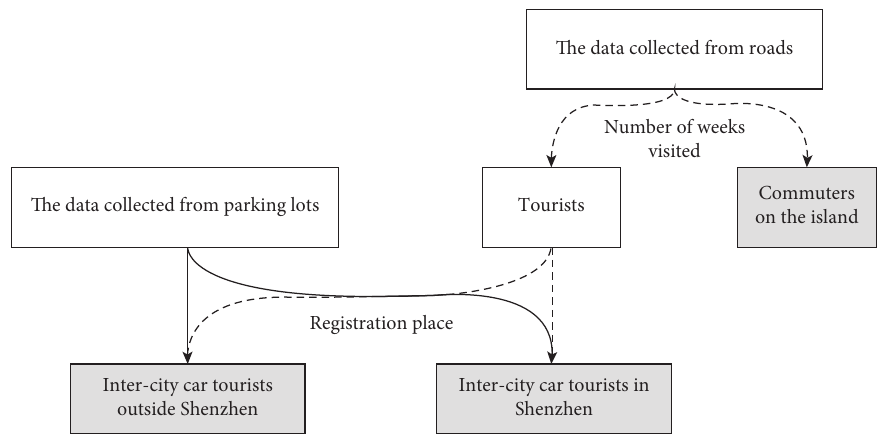
Figure 4: The workflow of traffic flow